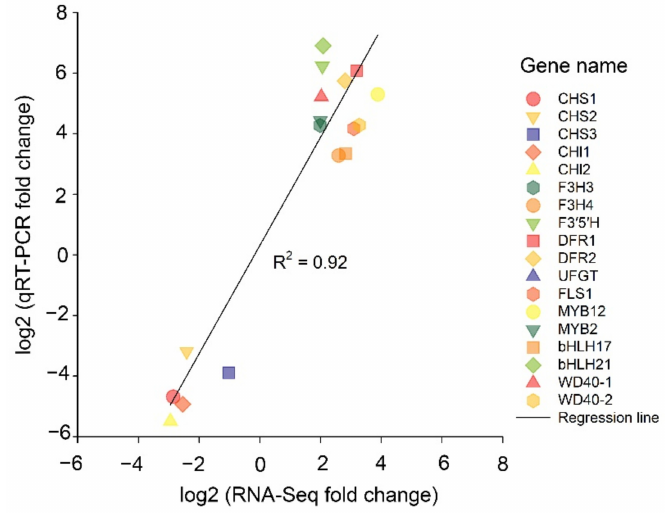
Figure 8. Correlation analysis between qRT-PCR and RNA-Seq results for CHS1 , CHS2 , CHS3 , CHI1 , CHI2 , F3H3 , F3H4 , F35H , DFR1 , DFR2 , UFGT , FLS1 , MYB12 , MYB2 , Bhlh17 , Bhlh21 , WD40-1 , and WD40-2 in Hydrangea macrophylla